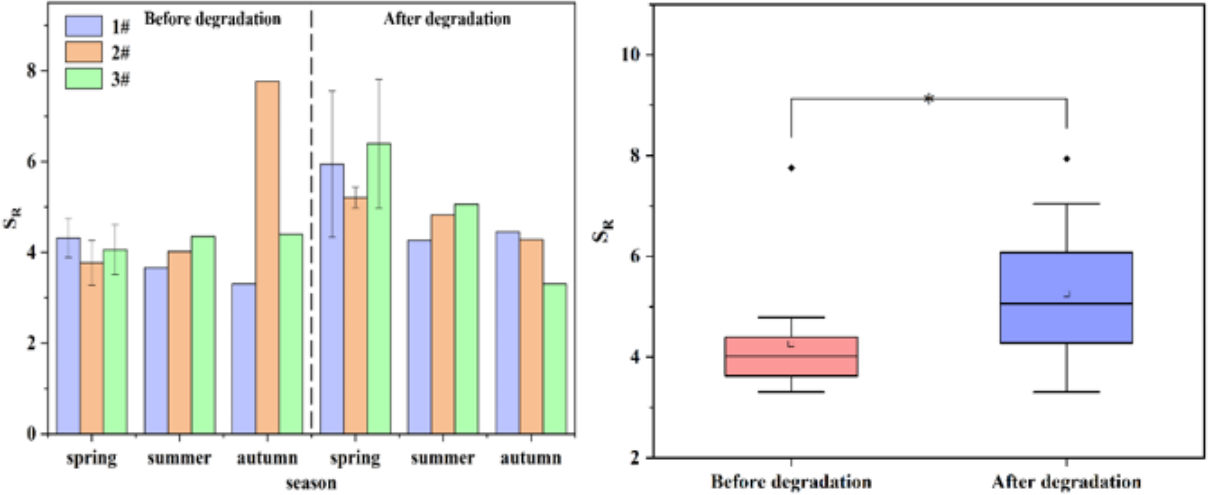
Figure 3. Spatial-temporal variation of S R in the Shili River before and after degradation. Right panel: The box-plot consists of five numerical points, minimum observation (bottom edge), 25% quantile (Q1), median, 75% quantile (Q3), and maximum observation (top edge). In the box-plot significance analysis, a * means it is significant at the 0.05 alpha level.